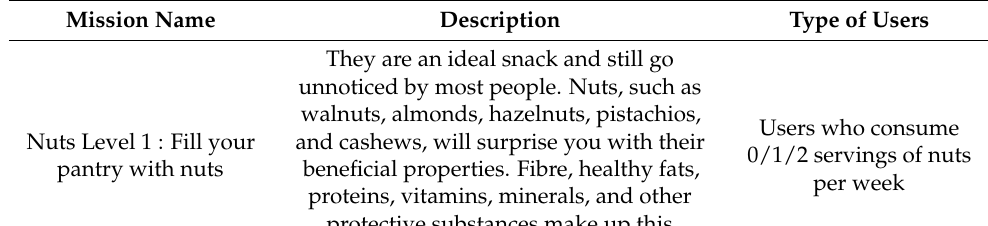
Table 1. Three levels of missions related to the food group Nuts